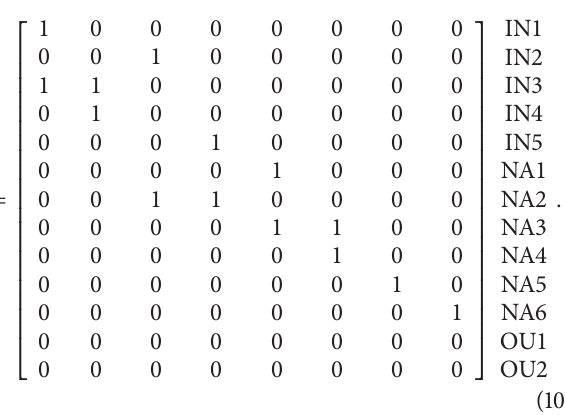
right, columns represent the types of logic gates and